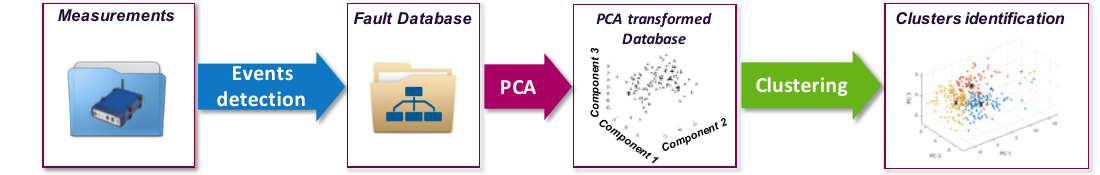
Figure 2. A frame of fault diagnosis based on multisensor